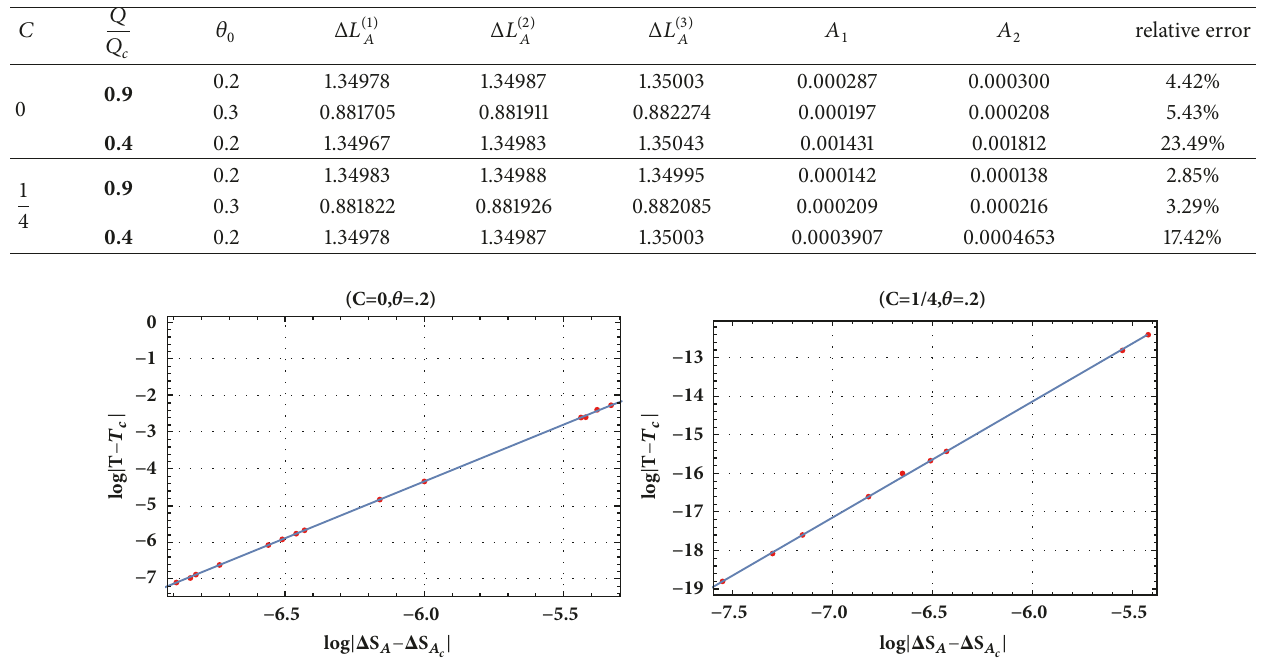
| for different 𝐶 . (Left) 𝐶 = 0 . (Right) 𝐶 ̸= 0 𝑐